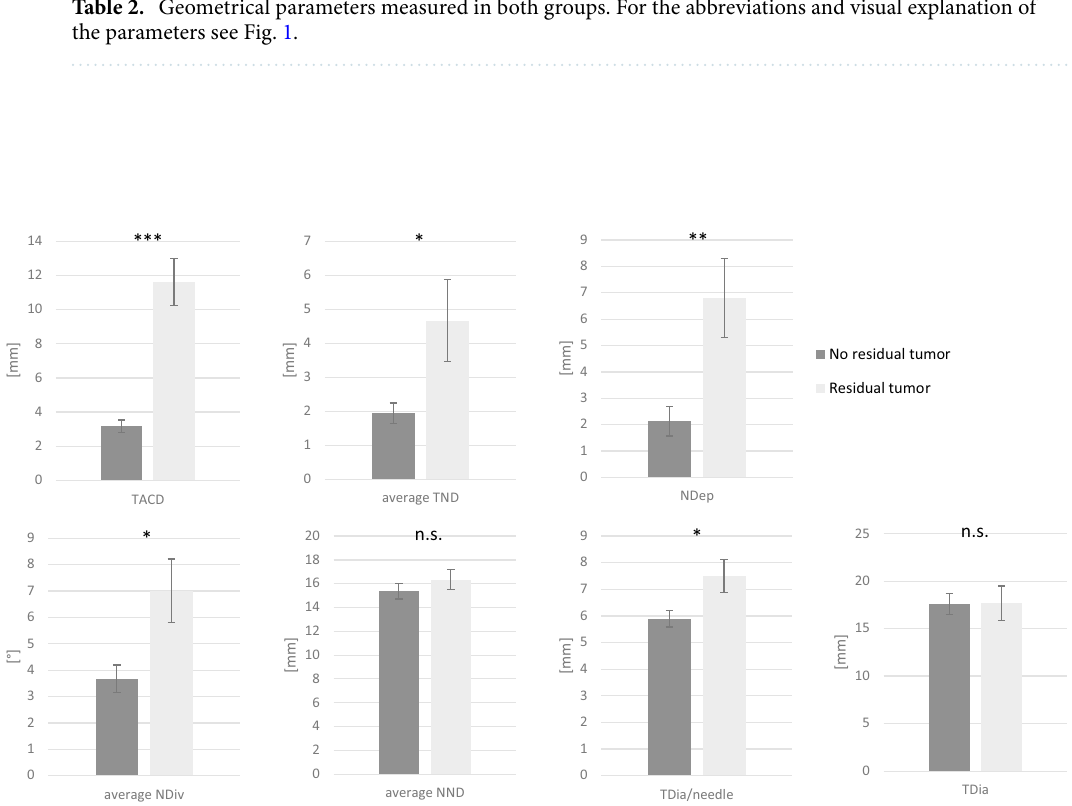
Figure 2. Comparison of the means of the geometrical parameters between patients without residual tumor (n = 30) and with residual tumor (n = 15). Parameters, which describe needle placement relative to the lesion (TACD, TND, NDep), as well as NDiv and TDia/needle, were significantly different. Means ± standard error. t tests between both groups. *** p < 0.001, ** p < 0.01, * p < 0.05, n.s. not